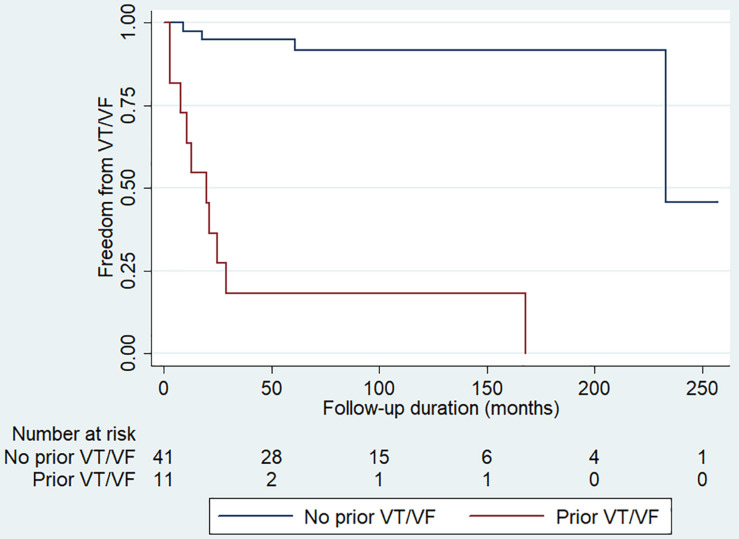
Kaplan-Meier curve demonstrating freedom from spontaneous ventricular tachycardia/ventricular fibrillation (VT/VF) during follow-up for patients with (red line) and without (blue line) prior VT/VF. P < 0.001 by the log-rank test.